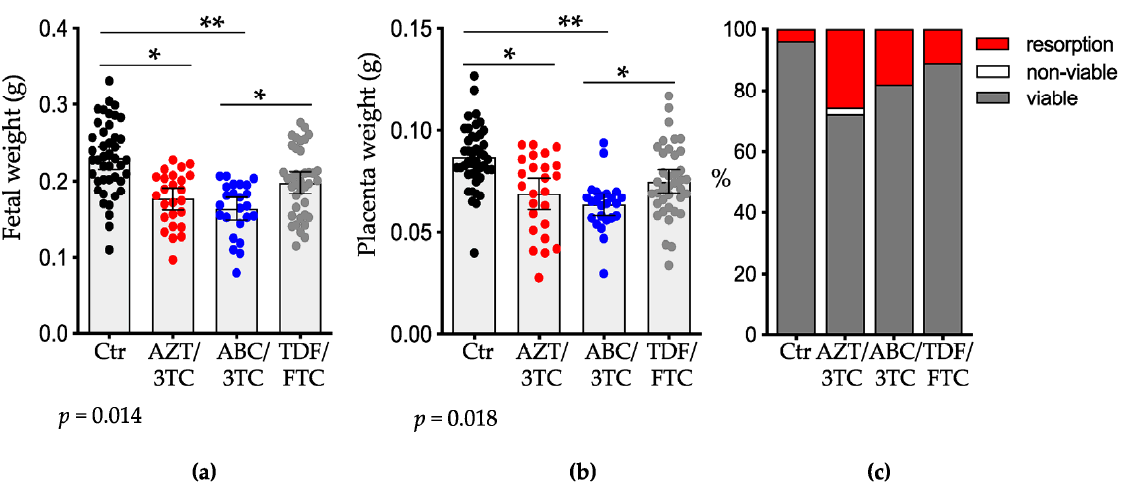
Figure 1. Maternal exposure to dual NRTIs is associated with lower fetal and placental weights. ( a ) Fetal weights; ( b ) placental weights; ( c ) viability and resorptions at gestational day 15 of mice treated with either AZT/3TC (red dots), ABC/3TC (blue dots), TDF/FTC (grey dots), or water (control; black dots). Data shown as scatter dot plots with mean and 95% confidence interval for ( a , b ). n = 43 fetuses/placentas from 6 litters for control; n = 25 fetuses/placentas from 6 litters for AZT/3TC; n = 24 fetuses/placentas from 5 litters for ABC/3TC; n = 40 fetuses/placentas from 7 litters for TDF/FTC. Statistical comparisons by mixed-effects modelling to control for litter effects (using treatment as a fixed effect and litter as a random effect). * = p < 0.05, ** = p < 0.01. AZT,